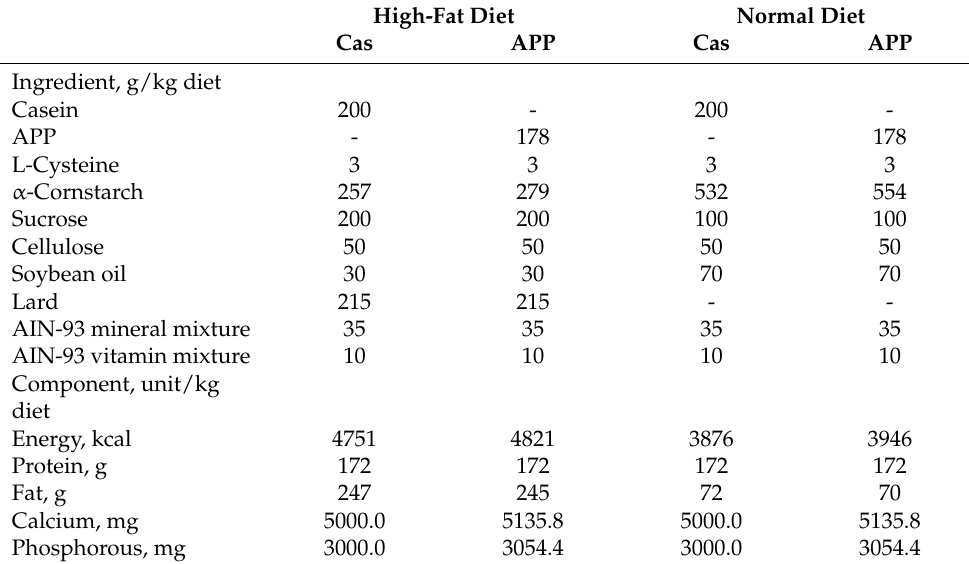
Table 2. Compositions of the experimental diets (g/kg diet).